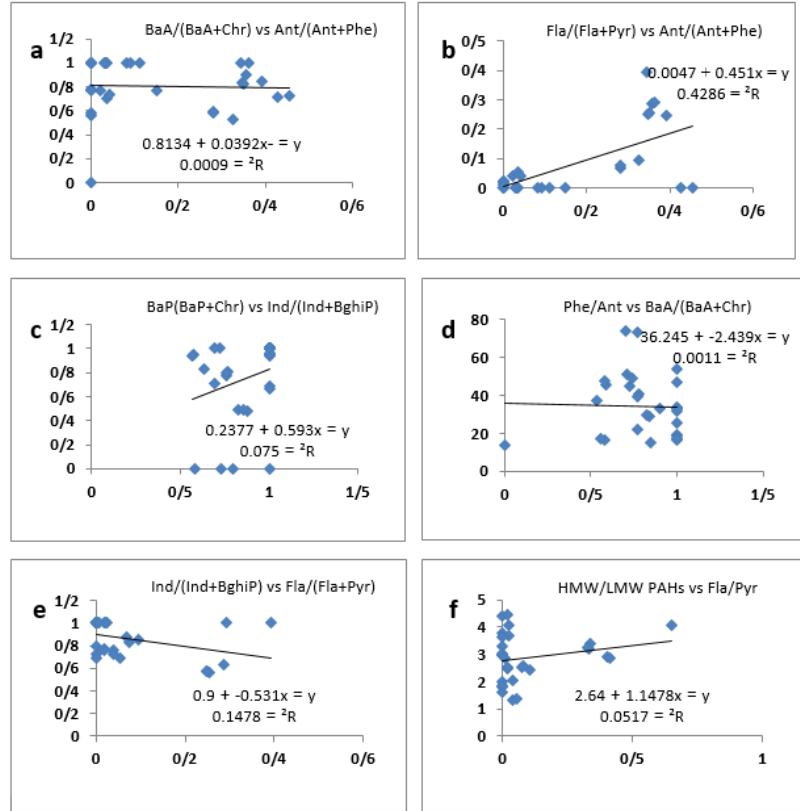
Fig. 3: Cross plot for the diagnostic ratios a. BaA/(BaA+Chr) vs Ant/(Ant+Phe), b. Fla/(Fla+Pyr) vs Ant/(Ant+Phe), c. BaP/(BaP+Chr) vs Ind/ (Ind+BghiP), d. Phe/Ant vs BaA/(BaA+Chr), e. Ind/(Ind+BghiP) vs Fla/(Fla+Pyr), f. HMW/LMW PAHs vs Fla/Pyr in soil